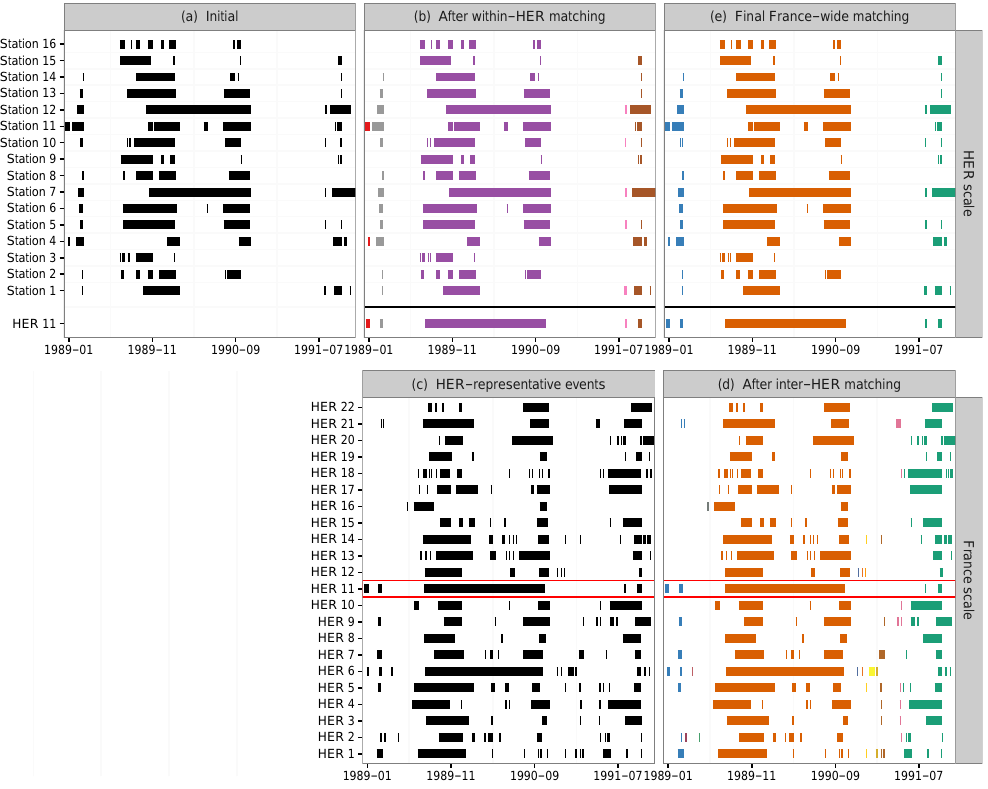
Figure 5. Spatial matching procedure for the local events reconstructed from Safran Hydro over the 1989–1991 period, through the example of the 16 stations in HER 11. The different panels of this figure are obtained by the procedures described in Fig. 4. (a) Independent events represented by black bars (see bottom of Fig. 3). (b) Matched events after within-HER matching. Each colour defines a spatio-temporal event at the HER scale. HER 11 representative events are represented at the bottom of the panel. (c) HER-representative events for the 22 HERs. Each black bar represents one event. (d) Matched HER-representative events after inter-HER matching. (e) Spatial HER-representative events matching reported to local events after France-wide matching. Each colour defines a spatio-temporal event at the France scale.